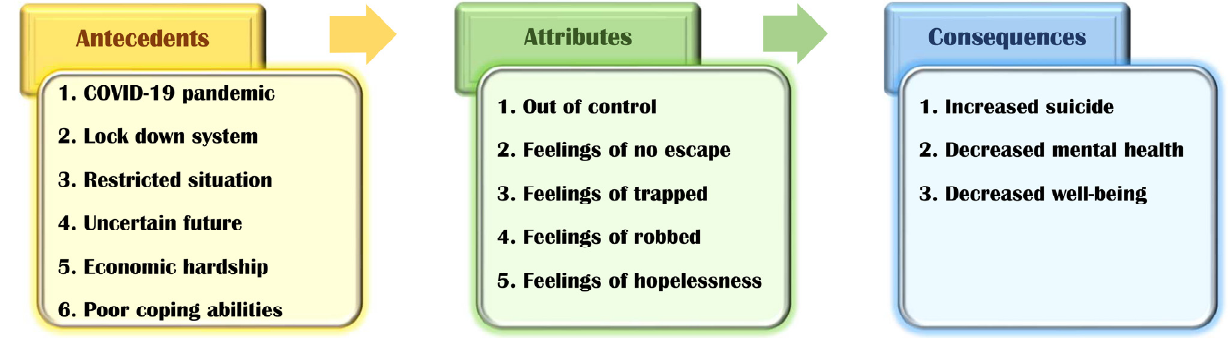
Figure 3. Concept diagram of “Feelings of entrapment”.